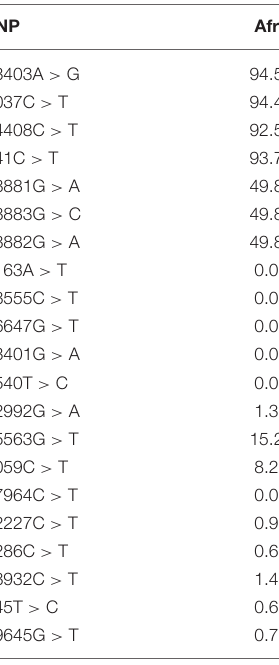
TABLE 1 | Top-20 recurrent variants and their frequencies in 5 different geographic